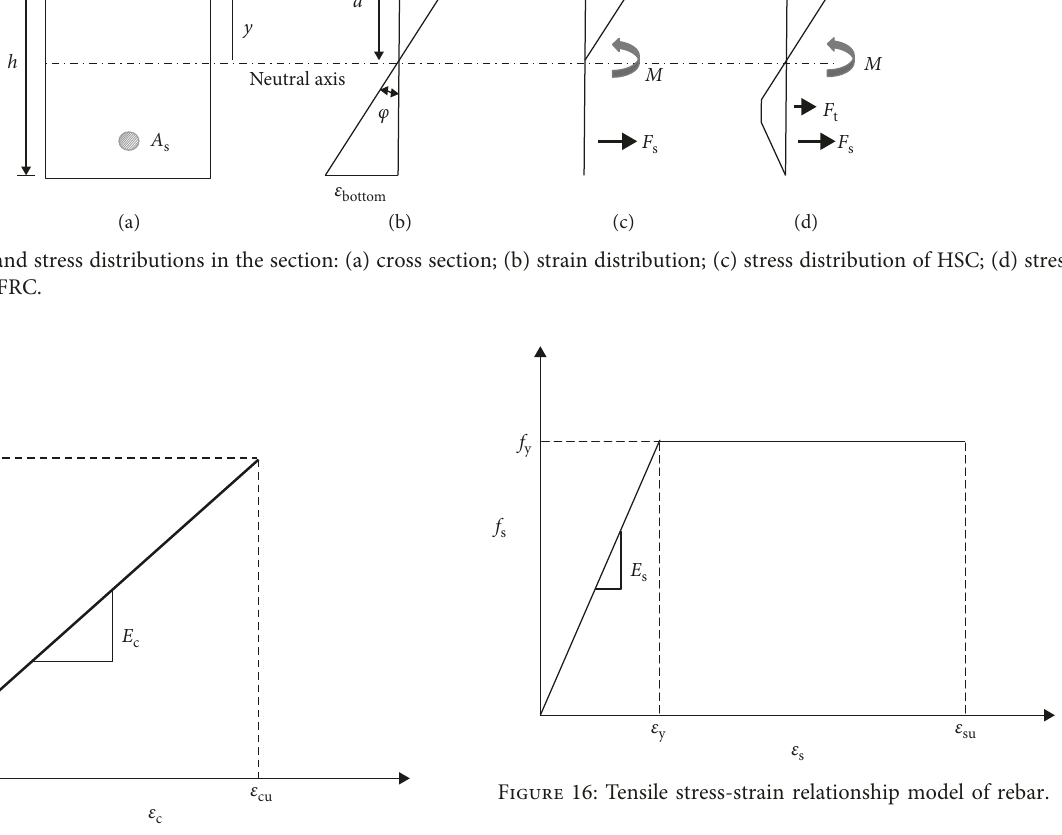
Figure 15: Compressive stress-strain relationship model of con- crete for HSC and HSFRC.